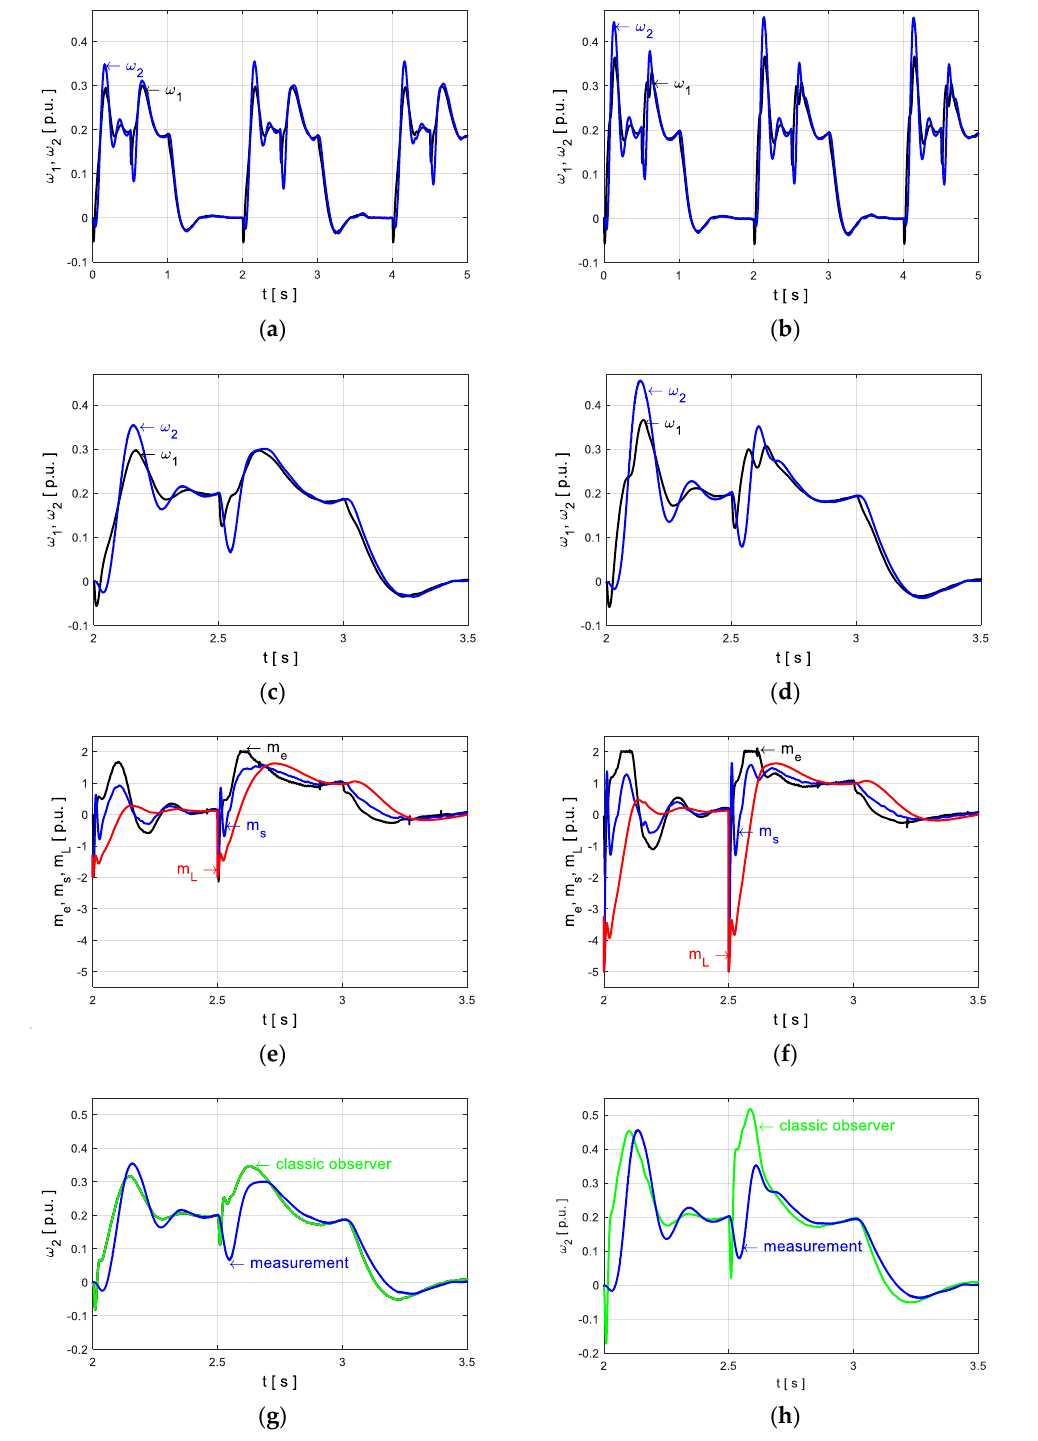
Figure 10. Transients of the system states: motor and load speeds ( a , b ) and it’s fragment ( c , d ), electromagnetic, estimated shaft and load torques ( e , f ), real and estimated load speed ( g , h ) for the system working in closed-loop structure with classical observers – case 1 ( a , c , e , g ) and case 2 ( b , d , f , h ) – experiment. As can be expected, improper values of the initial condition affected properties of the system. At the start-up, both speeds exhibited a visible drop. Then, the overshoot in the